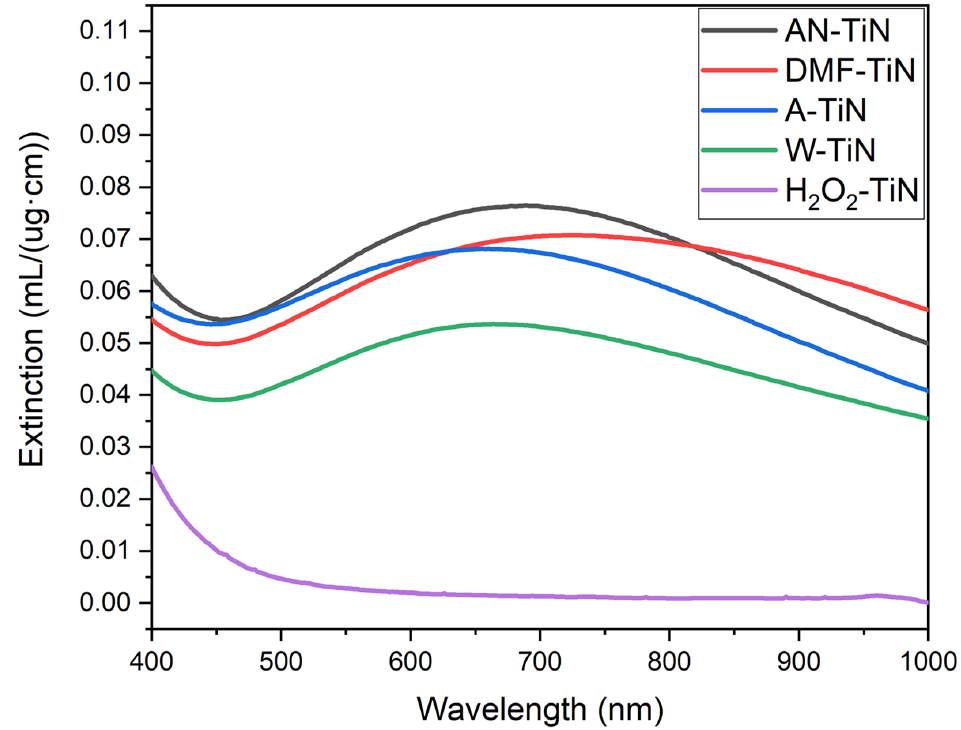
Figure 4. Optical extinction spectra of H 2 O 2 -TiN (purple), W-TiN (green), A-TiN (blue), DMF-TiN (red), and AN-TiN (black) NPs measured in 10 mm optical cuvettes and normalized to mass concentration of Ti in ug/mL.